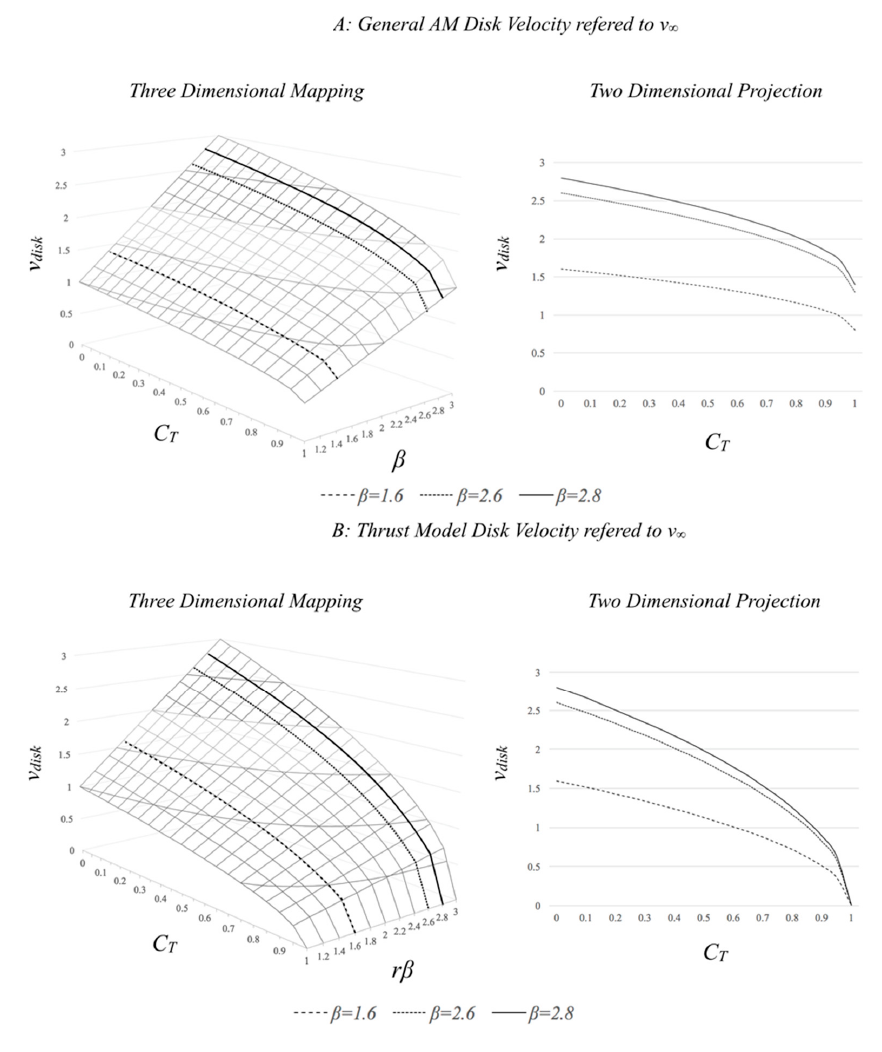
Figure 11. ( A ) General AM Disk Velocity related to C T ( B ) Thrust Model Disk Velocity related to C T .